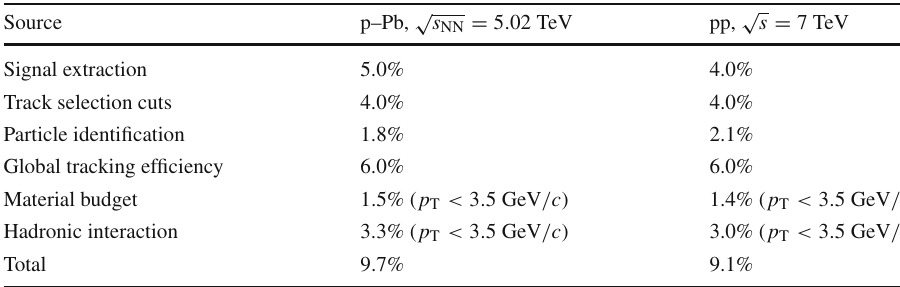
Table 2 Sources of